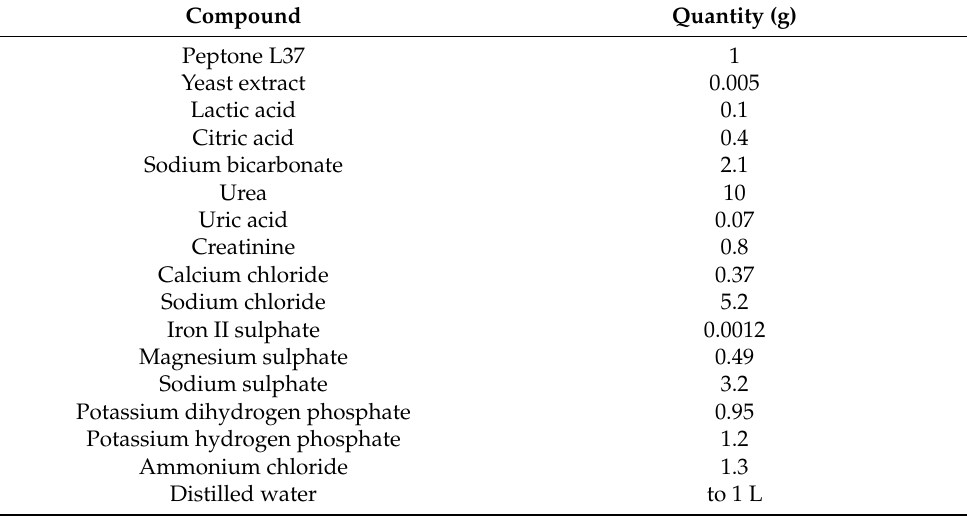
Table 1. Composition of urine-mimicking AUM, adjusted to pH 6.4, adapted with permission from Ref. [31] 2003, John Wiley and Sons. Compound Quantity (g) Peptone L37